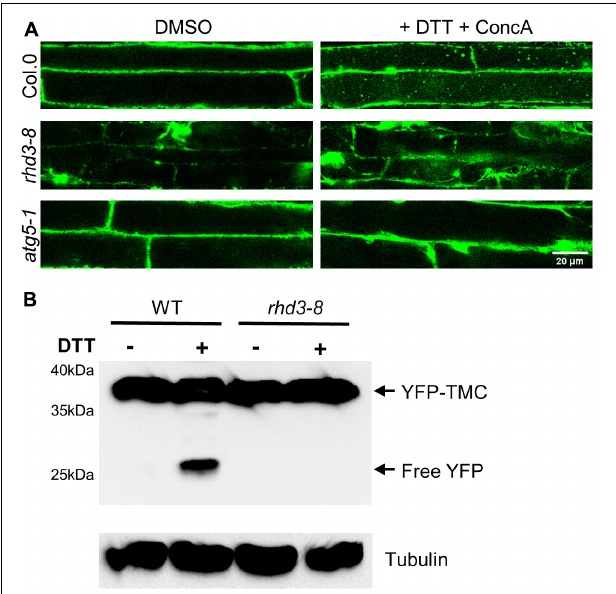
FIGURE 3 | Endoplasmic reticulum (ER)-phagy in rhd3 mutant is defective. (A) Confocal microscopic images of root cells of WT, rhd3-8 , and atg5-1 plants expressing YFP-TMC in the absence (DMSO) and presence of 10 mM DTT with ConcA. Scale bars = 20 µ m. (B) Western blot of YFP-TMC expressed in WT and rhd3-8 seedlings treated with or without 10 mM DTT for 4 h. Tubulin was used as the loading control.